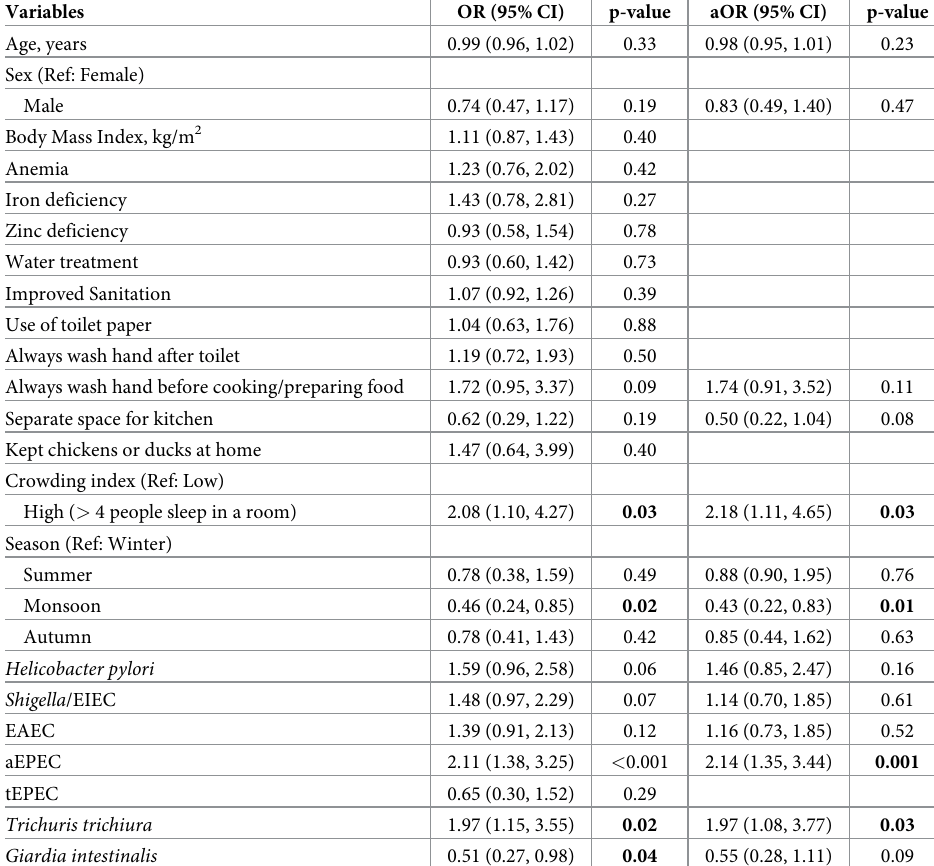
Table 2. Factors associated with Blastocystis infection in malnourished adults 1